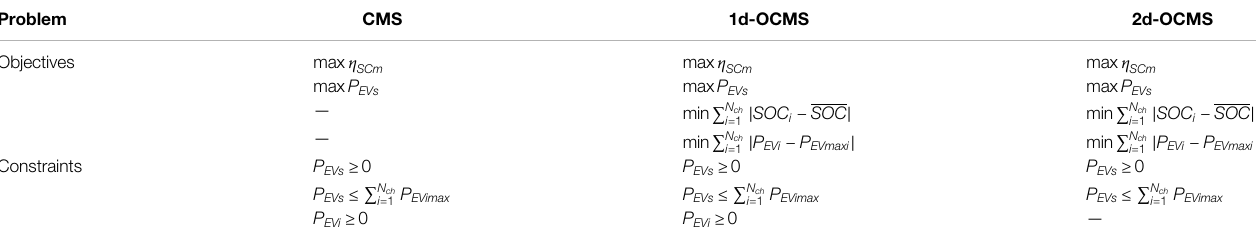
TABLE 3 | Problem ’ s objectives and constraints of the proposed charging management systems. Problem CMS Objectives